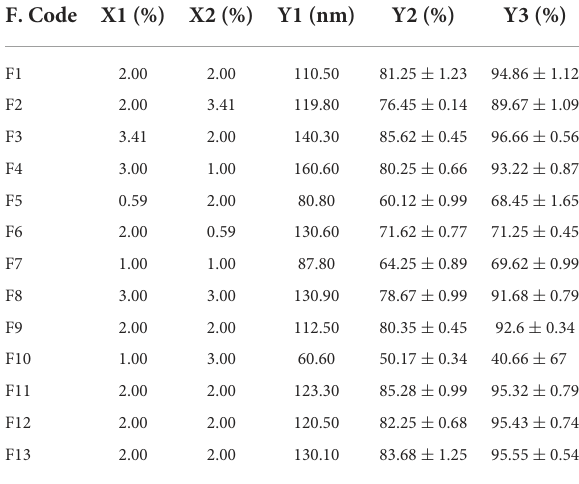
TABLE 1 Experimental runs designed by CCD and the obtained